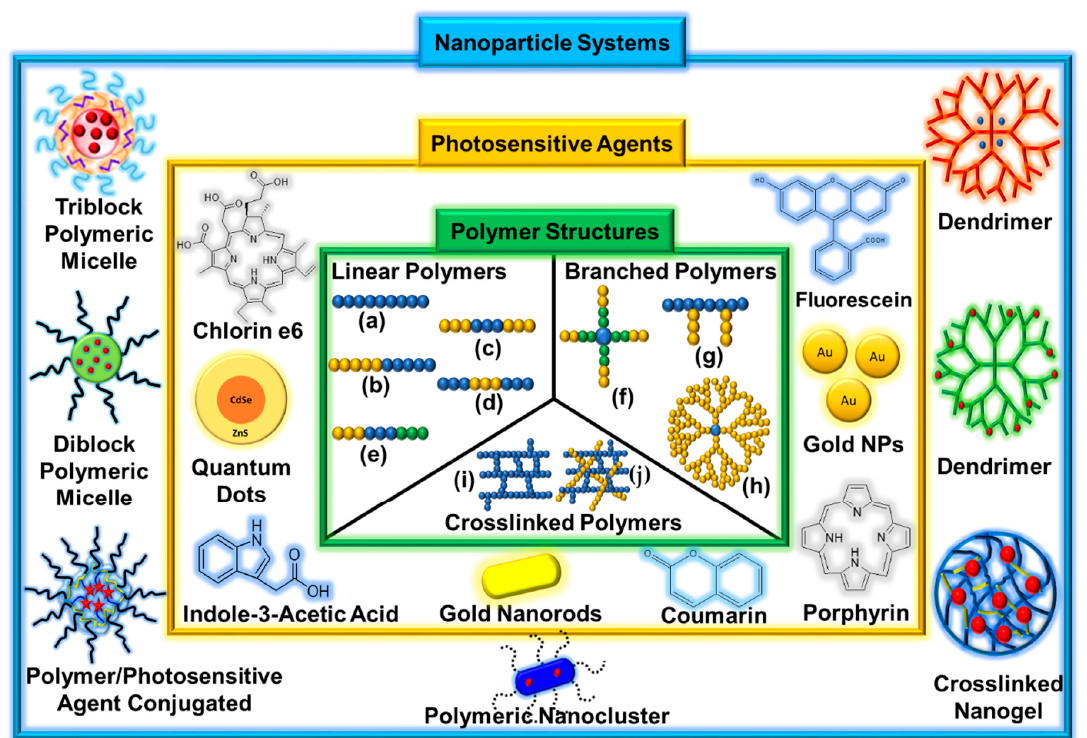
Figure 2. Schematic illustration of polymer structures, photosensitive agents, and nanoparticle systems. ( a ) Homopolymer, ( b ) AB-type diblock copolymer, ( c ) ABA-type triblock copolymer, ( d ) BAB-type triblock copolymer, ( e ) ABC-type triblock copolymer, ( f ) star-shaped block copolymer, ( g ) graft copolymer, ( h ) dendrimer, ( i ) polymer networks, and ( j ) interpenetrating polymer networks (IPN).